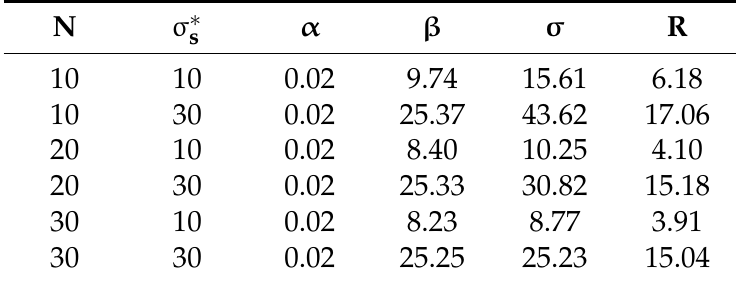
Table 1. The parameters in certain cases.